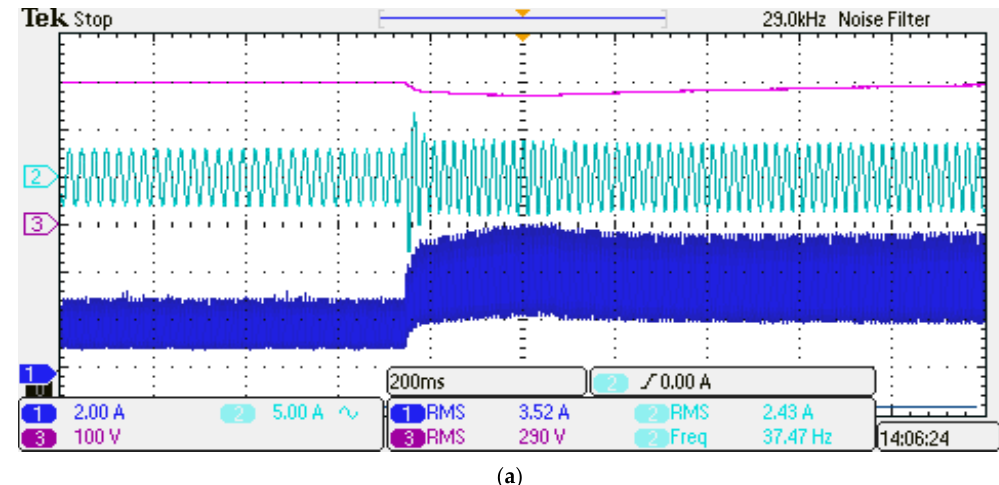
Figure 12. Experimental results at step change from 2A to 4A of the inductor current: ( a ) the proposed Q V/f; ( b ) the conventional L V/f PI-PI (Trace 1: Inductor current, Trace 2: Inverter phase current, Trace 3: DC-link